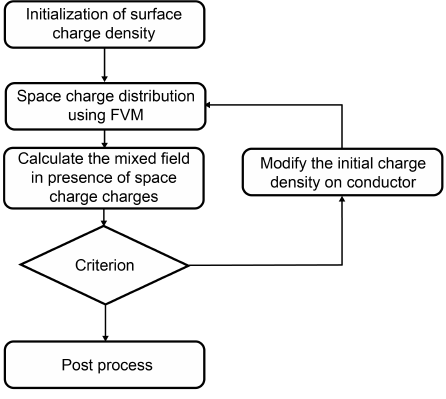
Figure 4. Flow chart of roughness factor